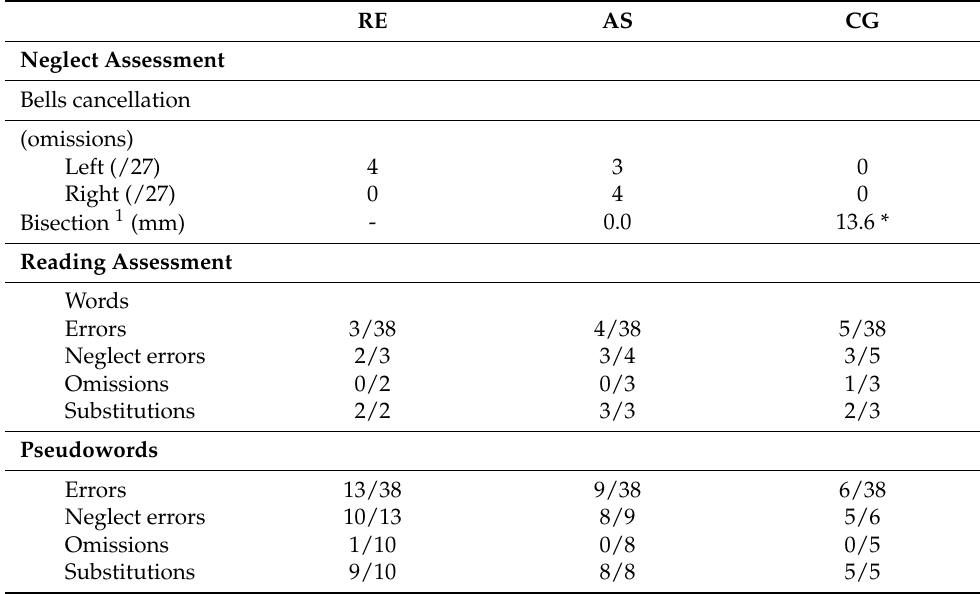
Table 2. Baseline assessment of Unilateral Spatial Neglect (USN) and Neglect Dyslexia (ND) for the three